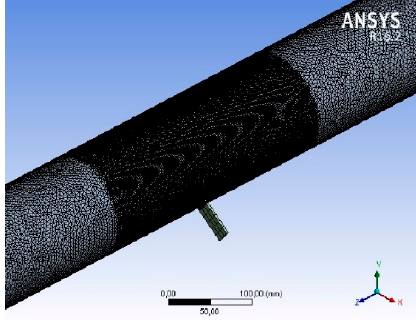
Figure 4. Tetrahedral mesh of the fluid domain for transversal orifice in Ansys environment.